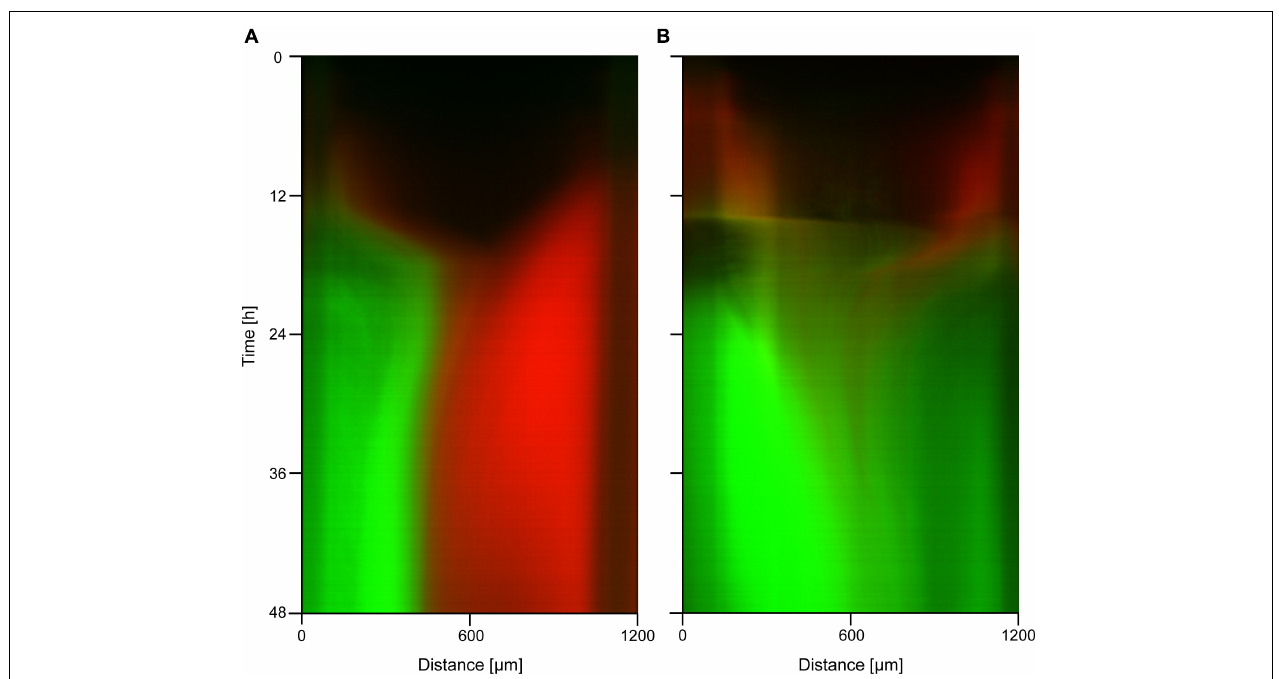
FIGURE 4 | Kymographs of fluorescence microscopy images taken during competition experiments of resistant mutants (s10/16; green color) and the non-resistant ancestor strain (red color) in ciprofloxacin gradients. The applied concentrations are (A) 2 × MIC on the left side; (B) 5 × MIC on the left side.